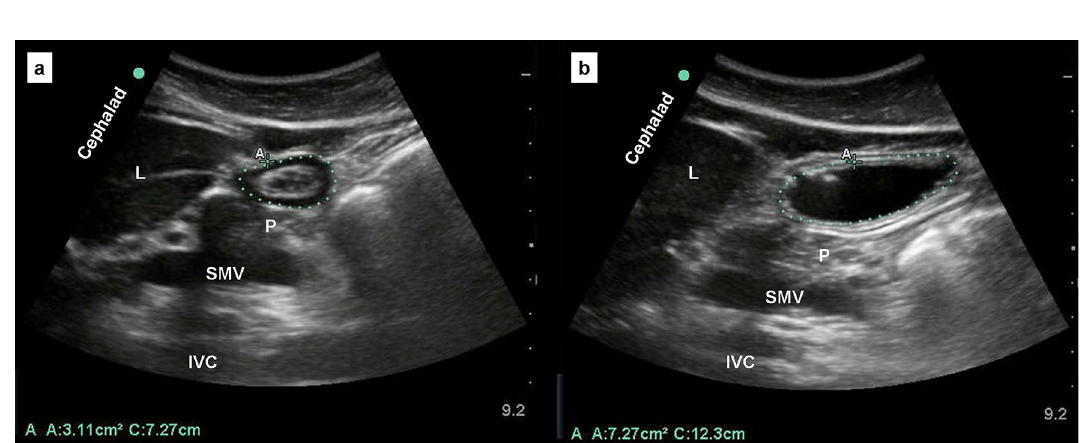
Figure 2. Antral ultrasound views from the same patient in the semirecumbent position ( a ) before and ( b ) after endoscopic endonasal transsphenoidal pituitary surgery. L: liver; P: pancreas; SMV: superior mesenteric vein; IVC: inferior vena cava. Dotted circle: gastric antrum.